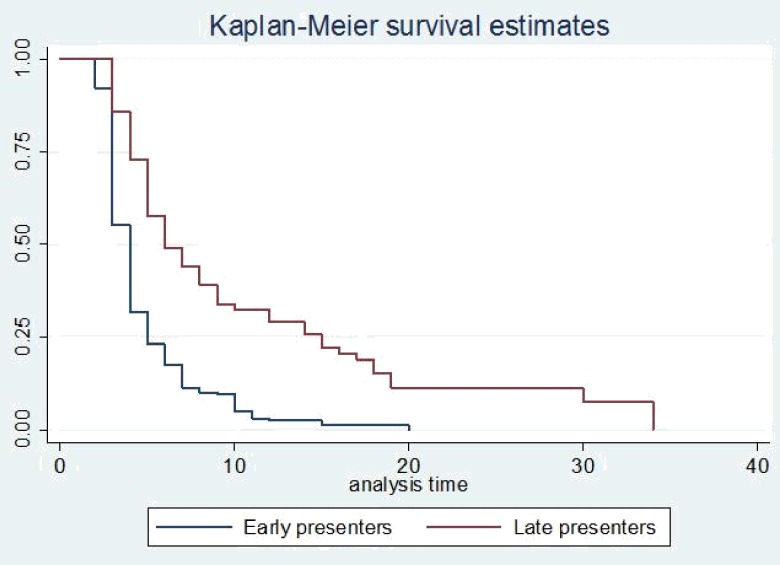
Kaplan-Meier survival estimate for time to recovery among SCAP children with duration to seek care.